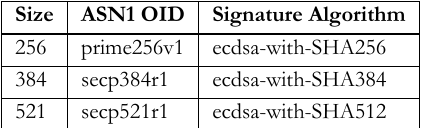
Table 1. Algorithms used to generate X.509 certificates and keys are not secure [12]